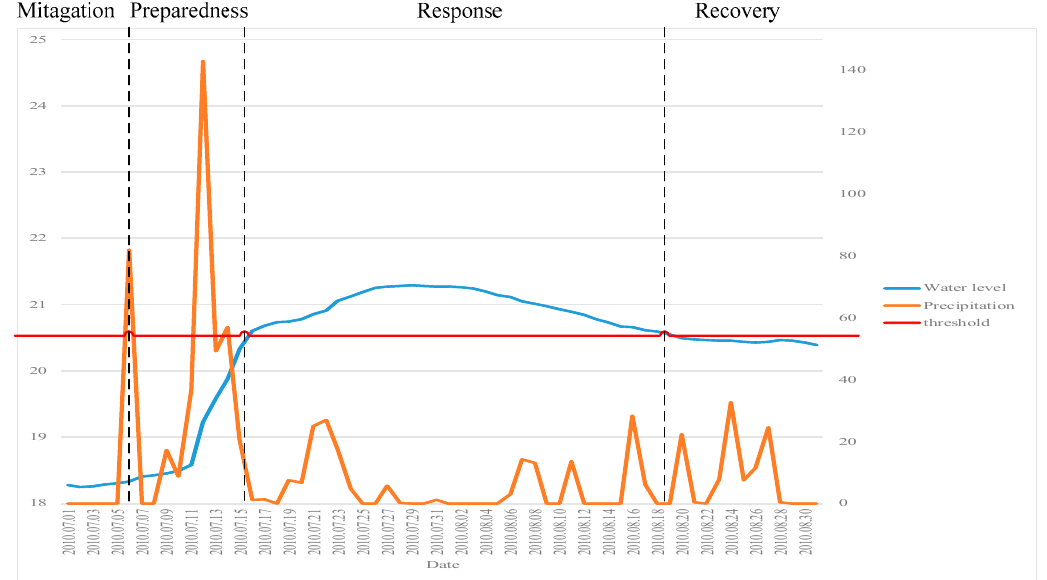
Figure 7. Stage divisions using the reasoning rules with data of the daily precipitation and water level at Liangzi Lake during the flood period in 2010.